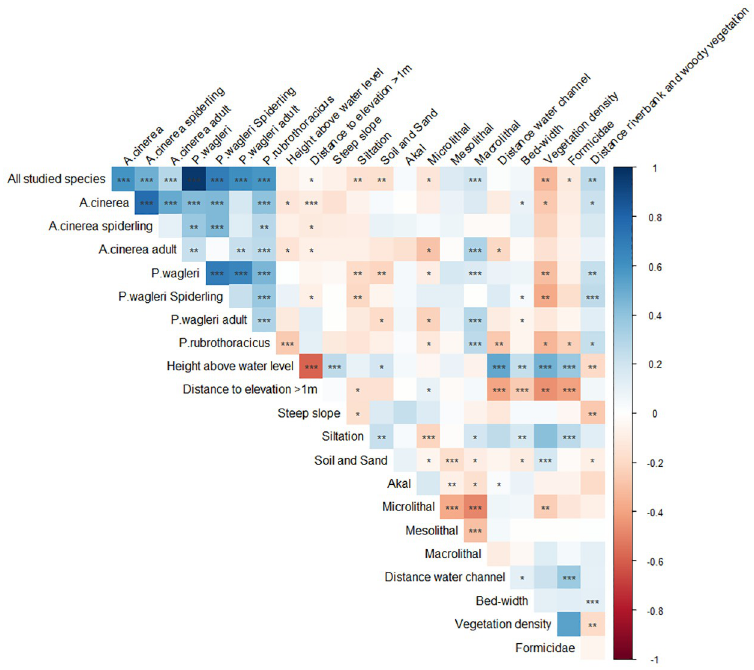
Fig 2. Correlation matrix after Spearman’s rank correlation (rho) and significant level stars. Color intensity of the glyph is proportional to the correlation coefficients.